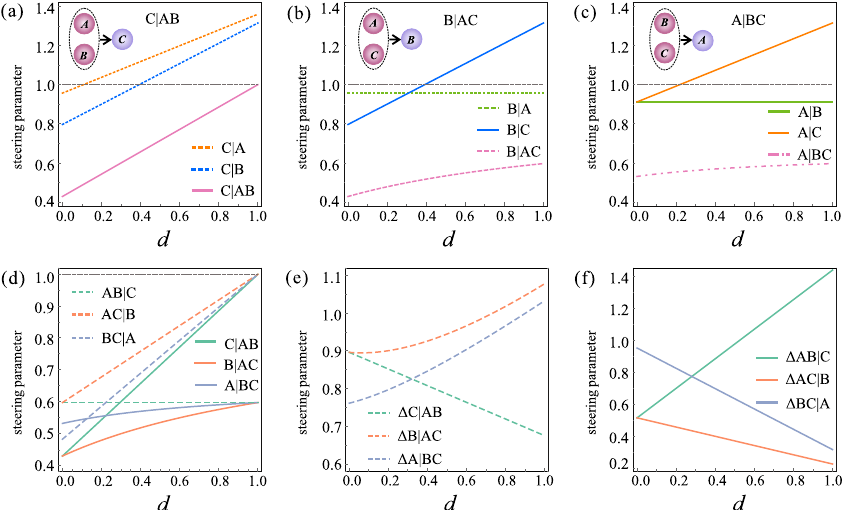
Figure 5. The effects of decoherence channels on the steerability between single party and group parties when 3 √ 2 / 5 , θ r = function of d . ( b ) The steering parameters ( c ) The steering parameters of decoherence on the direction of collective steering. ( e ) The monogamy relation for one steered party. ( f ) The monogamy relation for two steered parties. S corresponding types of steering, � S monogamy relation, where i